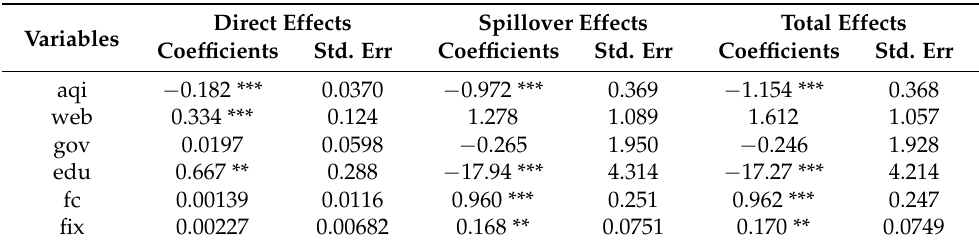
Table 6. Robust test with the alternative core explanatory